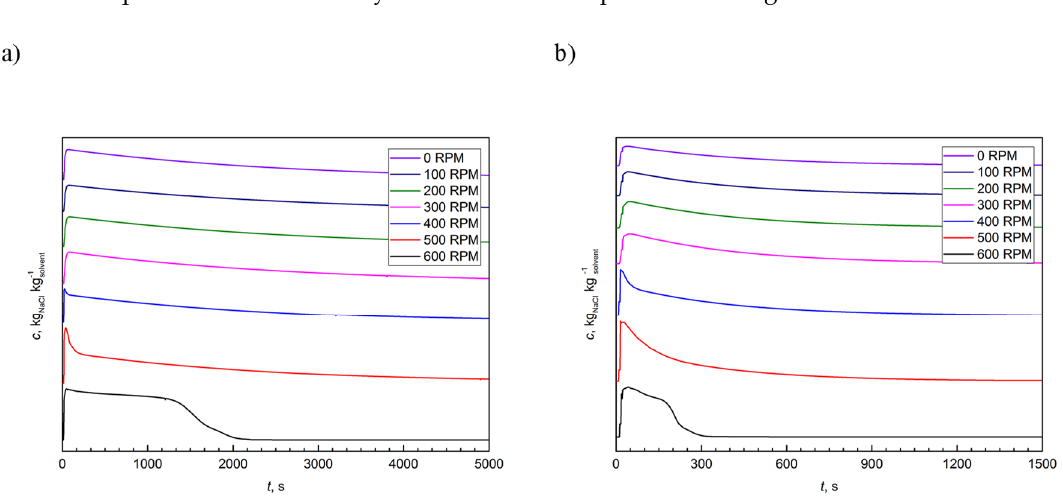
Figure 3. The typical example of residence time distribution (RTD) curves at di ff erent flow rates: ( a ) 10 dm 3 · h − 1 ; and ( b ) 60 dm 3 · h − 1